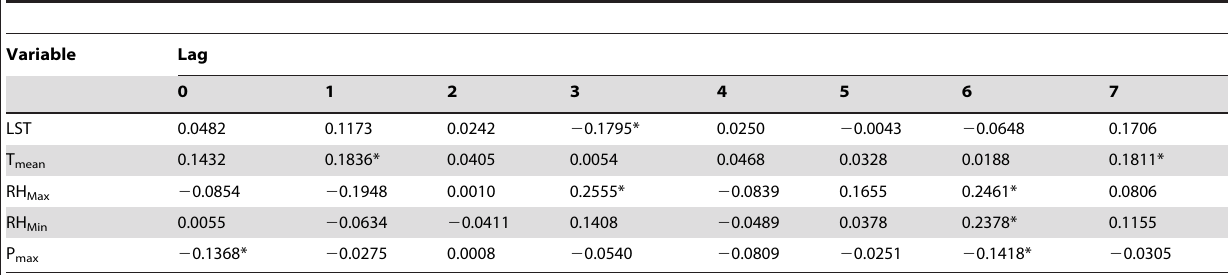
Table 4. Maricopa county: cross-correlations between influenza count and pre-whitened environmental series.